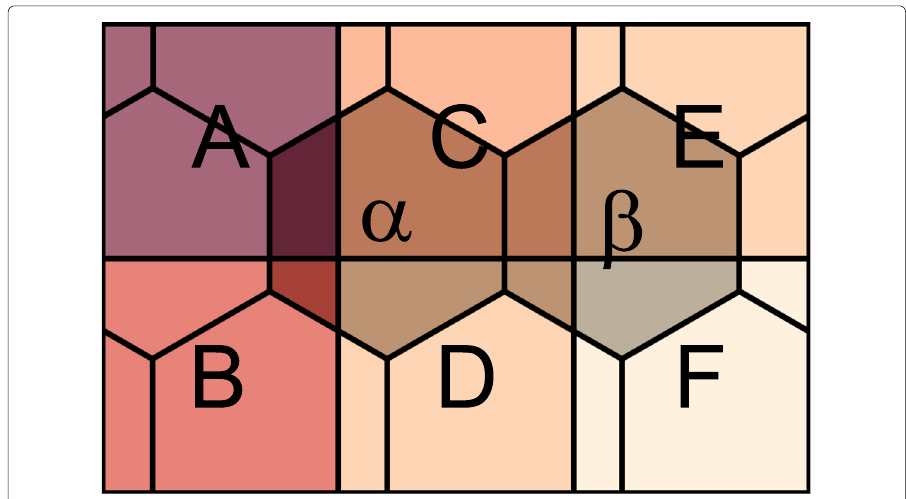
Fig. 1 Demonstration of proportional resampling of square grid population data to our hex grid. The hex α has an interpolated population value calculated from its proportional overlap with the population data grid spaces A, B, C, and D. The population value for hex β is similarly constructed from the square grid spaces C, D, E, and